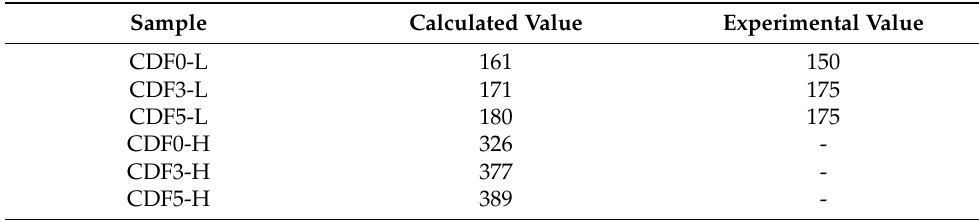
Table 7. The number of rapid freeze-thaw cycles of concrete with material